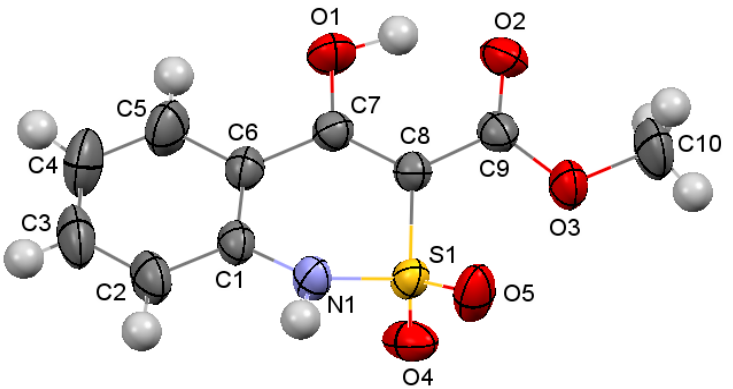
Figure 3. The molecular structure of ester 4a according to X-ray diffraction data. The atoms represented by thermal vibration ellipsoids of 50% probability.